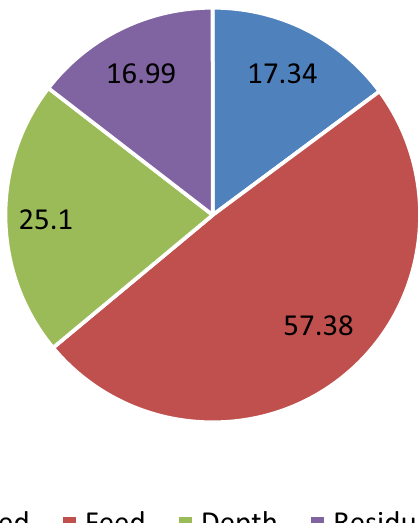
Fig. 5 Percentage contributions of factors for the